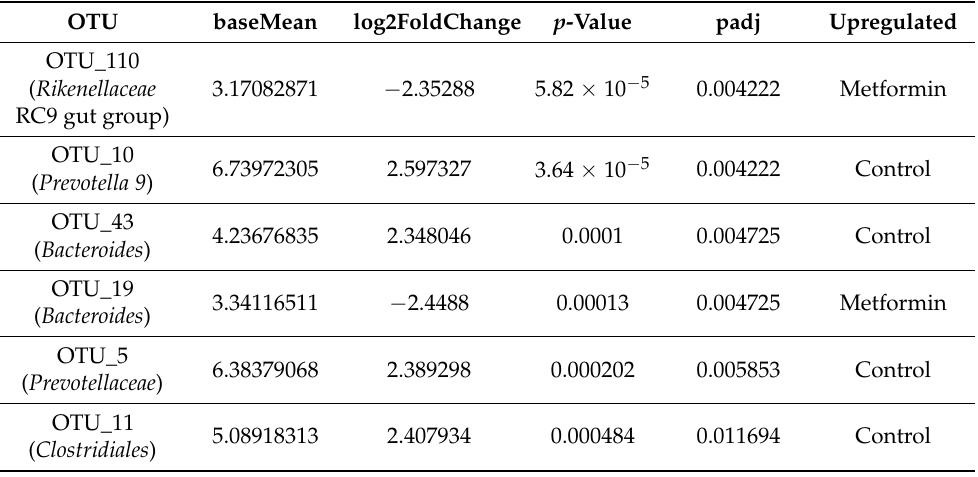
Table 4. Taxa differential of OTUs statistically modified when comparing Metformin treated MetSyn patients vs. naive patients. These are log 2-fold different and statistically